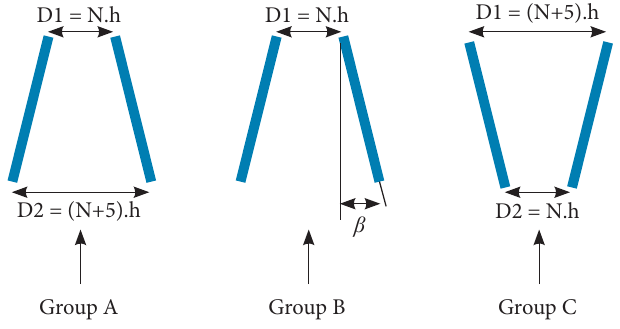
Figure 19. Parameters of VG geometry